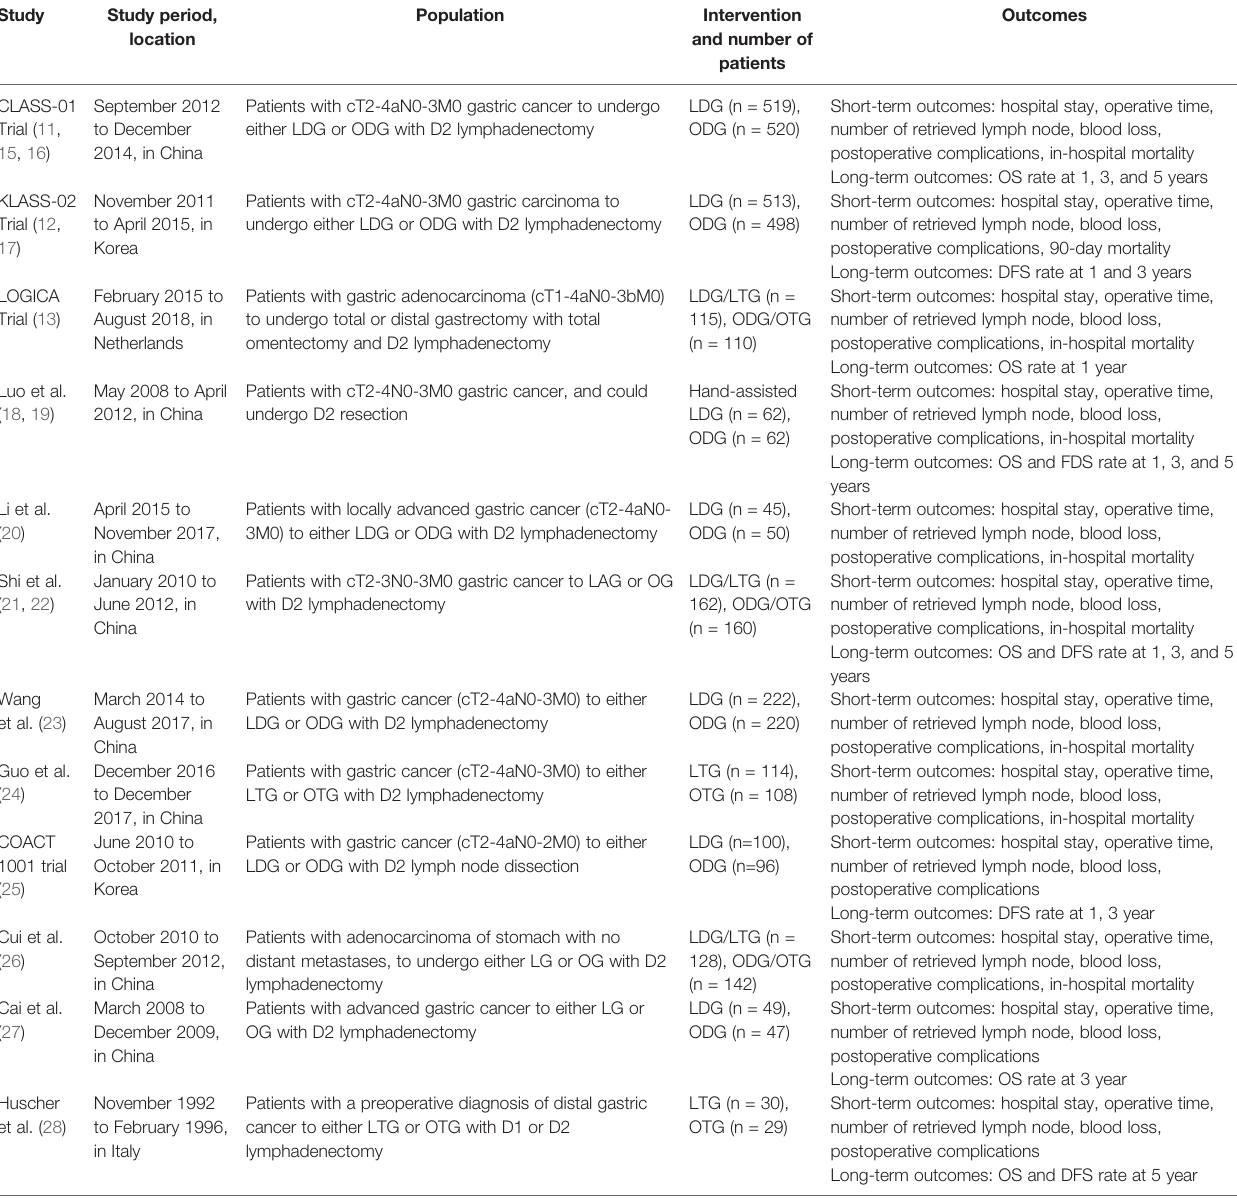
TABLE 1 | Characteristics of included